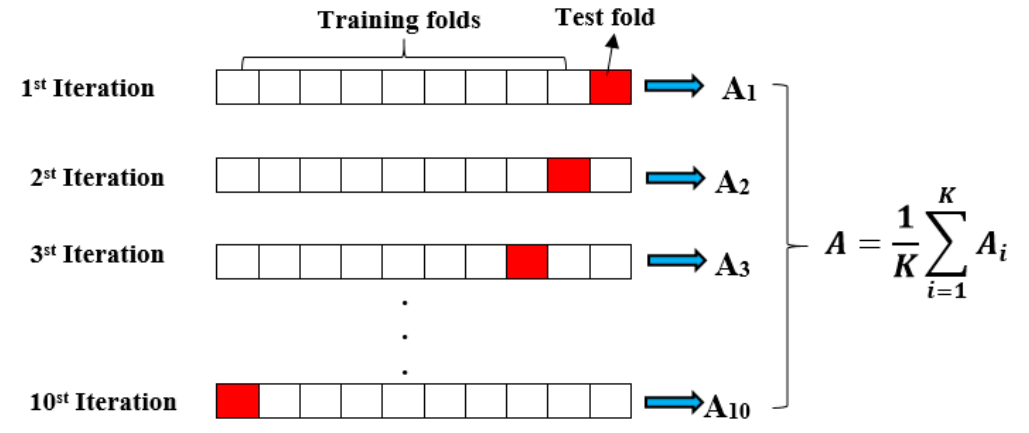
Figure 4. Schematic representation of cross validation (CV) implementation.